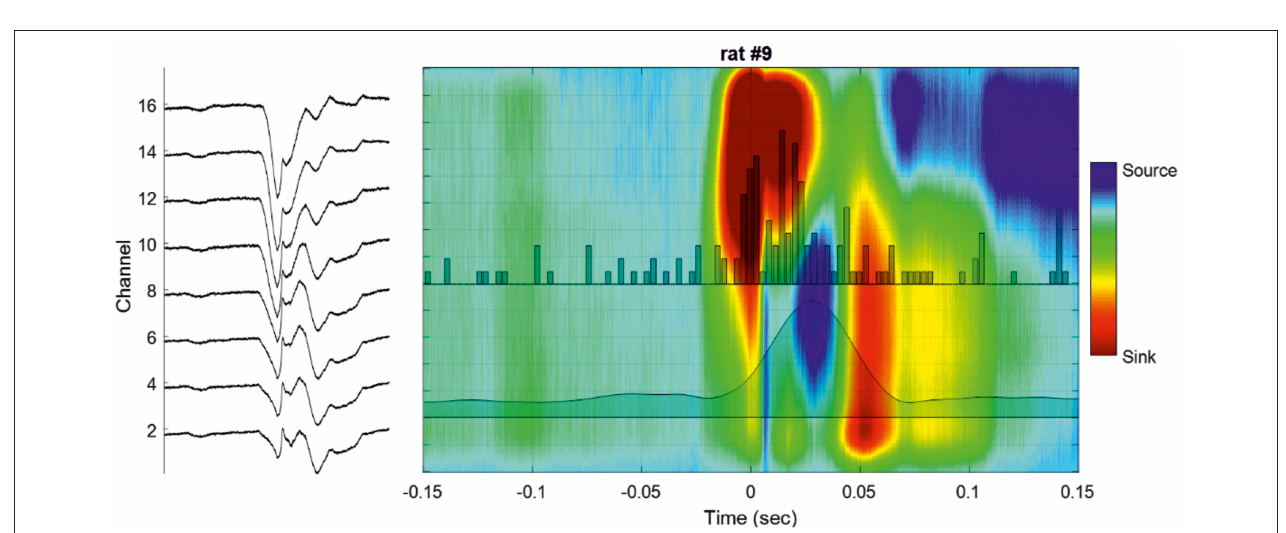
FIGURE 4 | Cortical analysis of the current source density (CSD) during a single IIS. (Left) LFP of a selected IIS at different recording depths. (Right) Current source density analysis of the signal of the global unit activity (LFP shown on the left side) with superimposed unit activity histograms (Channel 16). The averaged multiunit activities (MUA) of all the channels are superimposed on the